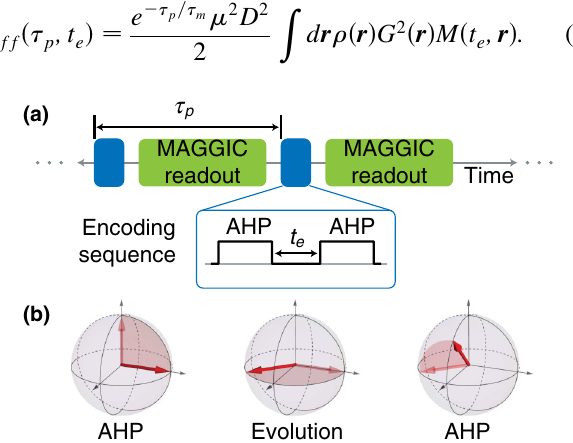
FIG. 2. Spin-noise encoding. (a) Periodic encoding pulses are inserted in the MAGGIC protocol every (cid:5) p . For the free- precession measurement, the sequence consists of two AHPs separated by an evolution period t e . (b) Illustration of the pulse sequence showing the evolution of a spin initially oriented along the z axis.